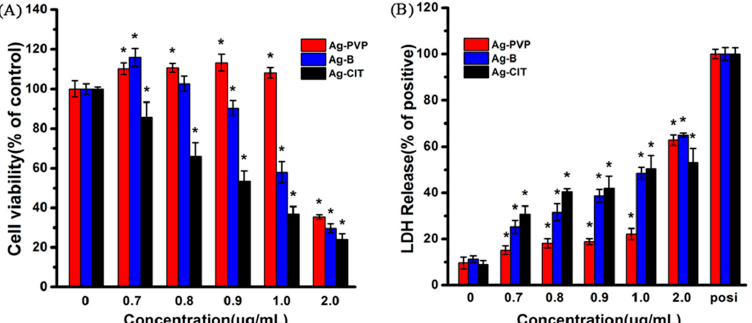
Figure 2. The viability ( A ) and LDH level ( B ) assays of Caco-2 cells after being exposed to three Ag NPs for 24 h. ( A ) Percent viable cells compared to no particle (0 μ g/mL) condition; and ( B ) percent LDH release compared to 100% cell lysis. All data are represented as the mean ± SD ( n = 6). * p < 0.05 comparing with the 0 μ g/mL control.